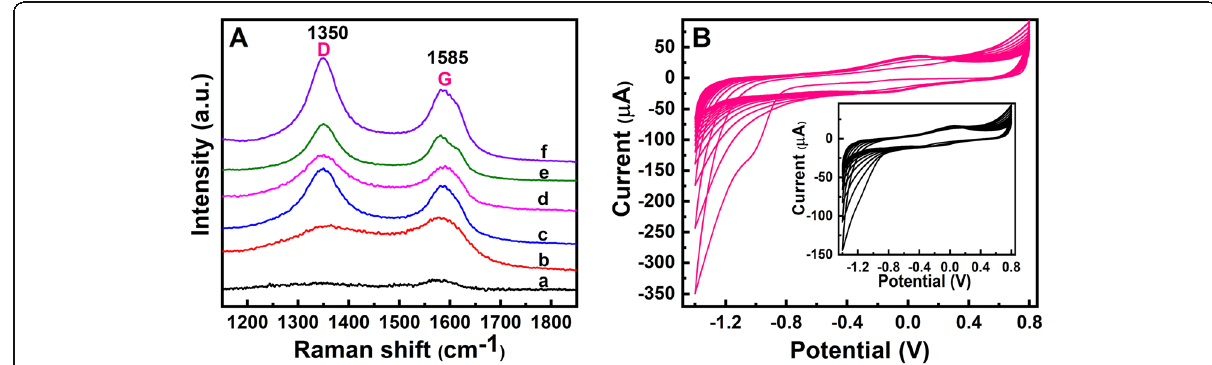
Fig. 2 A Raman spectra of ( a ) PPy, ( b ) GO, ( c ) ErGO, ( d ) ErGO/PPy, ( e ) ErGO/MWCNT/PPy, and ( f ) MWCNTs. b CV curves of the electrochemical deposition of GCE - GO/MWCNT/Py in